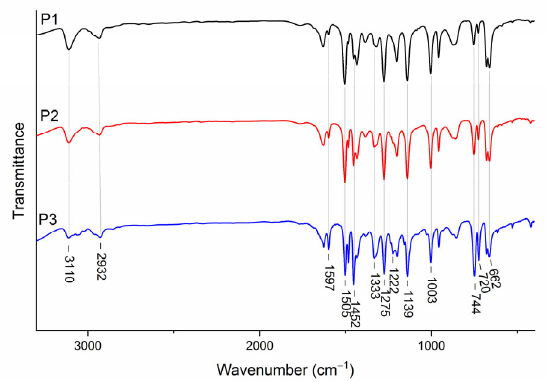
Figure 2. FT-IR spectra of P1–P3 poly(VT- co -VK) copolymers.